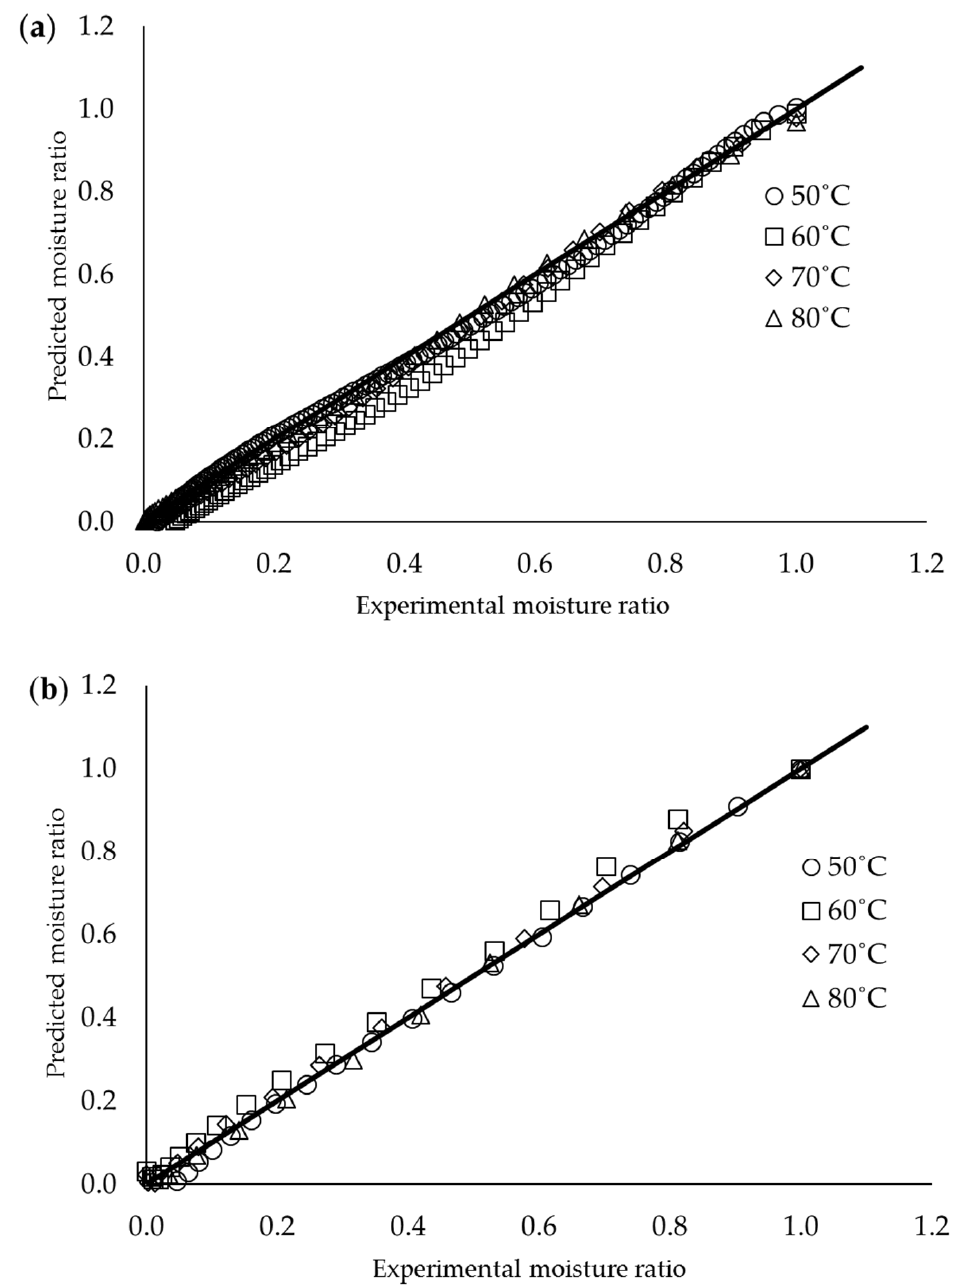
Figure 3. Predicted MR versus experimental MR under different drying temperatures: ( a ) oven drying logarithmic model, and ( b ) IR drying Wang–Singh model.